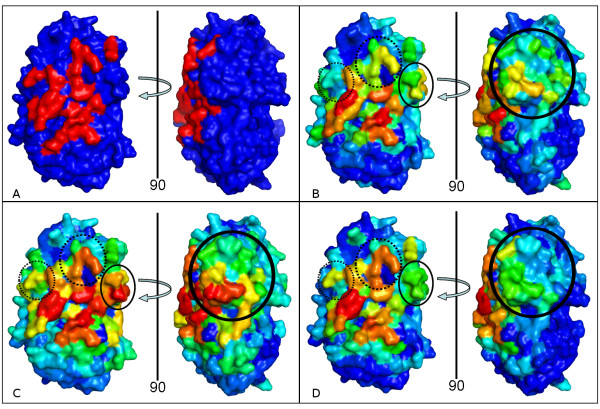
Evaluating the effect of environment descriptors. The binding site of CI-2-SUBTILISIN NOVO (PDB code: 2sni, chain E; surface representation) was predicted using structural, energy, conservation, and B-factor information and three different types of environments definitions. (A) Interface as in the crystal structure (highlighted in red). (B) Prediction using a 9-residues sliding window. (C) Prediction using distance threshold (15 Angstroms cut-off). (D) Prediction using VDs. The gradient colour represents score values (s) where: blue (0 ≤ s < 0.5), green (0.5 ≤ s ≤ 0.7), yellow (0.7 ≤ s < 0.9), and red (s > 0.9). Solid and dashed circles represent differences in the prediction of non-interface and interface residues, respectively.